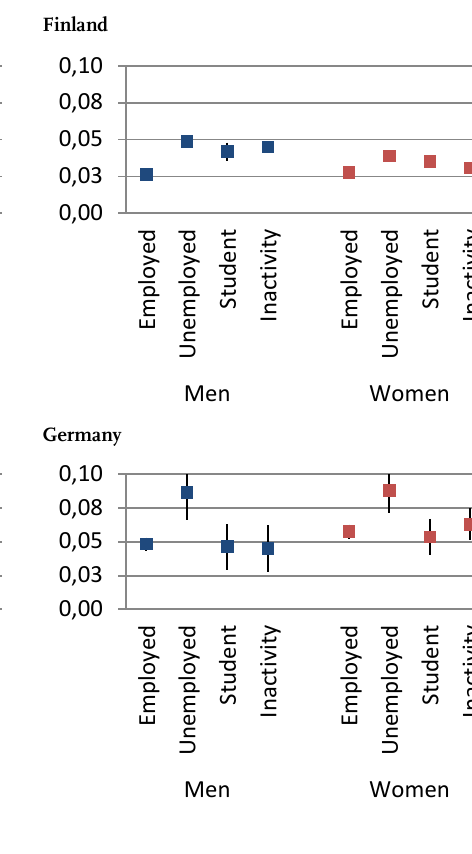
Figure A.1 : Divorce predicted probabilities for the most recent cohort of married